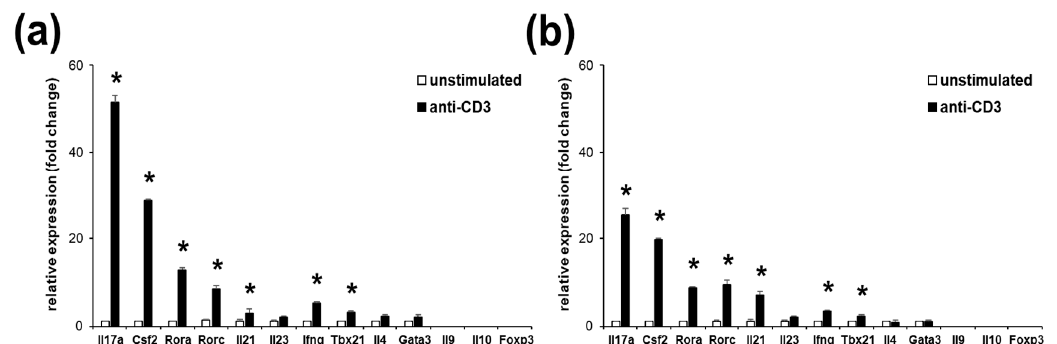
Figure 1. EL4 TCR + cells upregulate T helper cells (Th) type 17 genes in a manner similar to murine Th17 cells. Gene expression analysis of EL4 TCR + cells (a) or Th17 polarized murine cells following an anti-CD3 stimulation ( b ). Il17a, Csf2, Rora, Rorc, Il21 and Il23 are markers specific for Th17. Ifng and Tbx 21 are markers of Th1, Il4 and Gata3 are markers of Th2, Il9, Foxp3 and Il10 are markers of Th9,